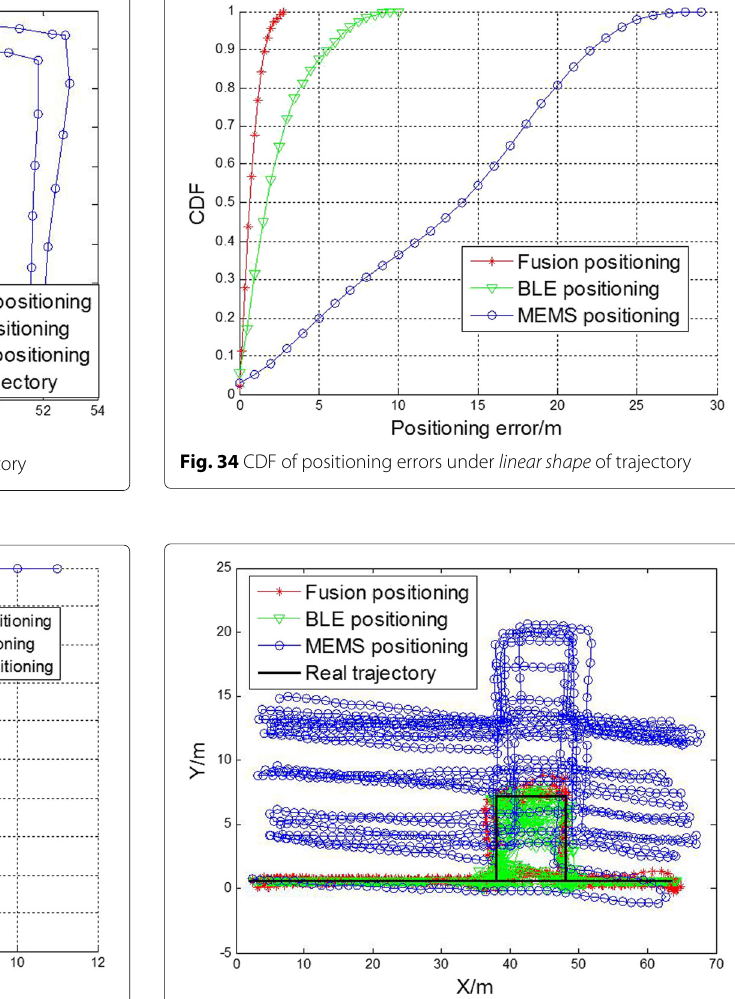
Fig. 35 Locations tracking under irregularshape of trajectory